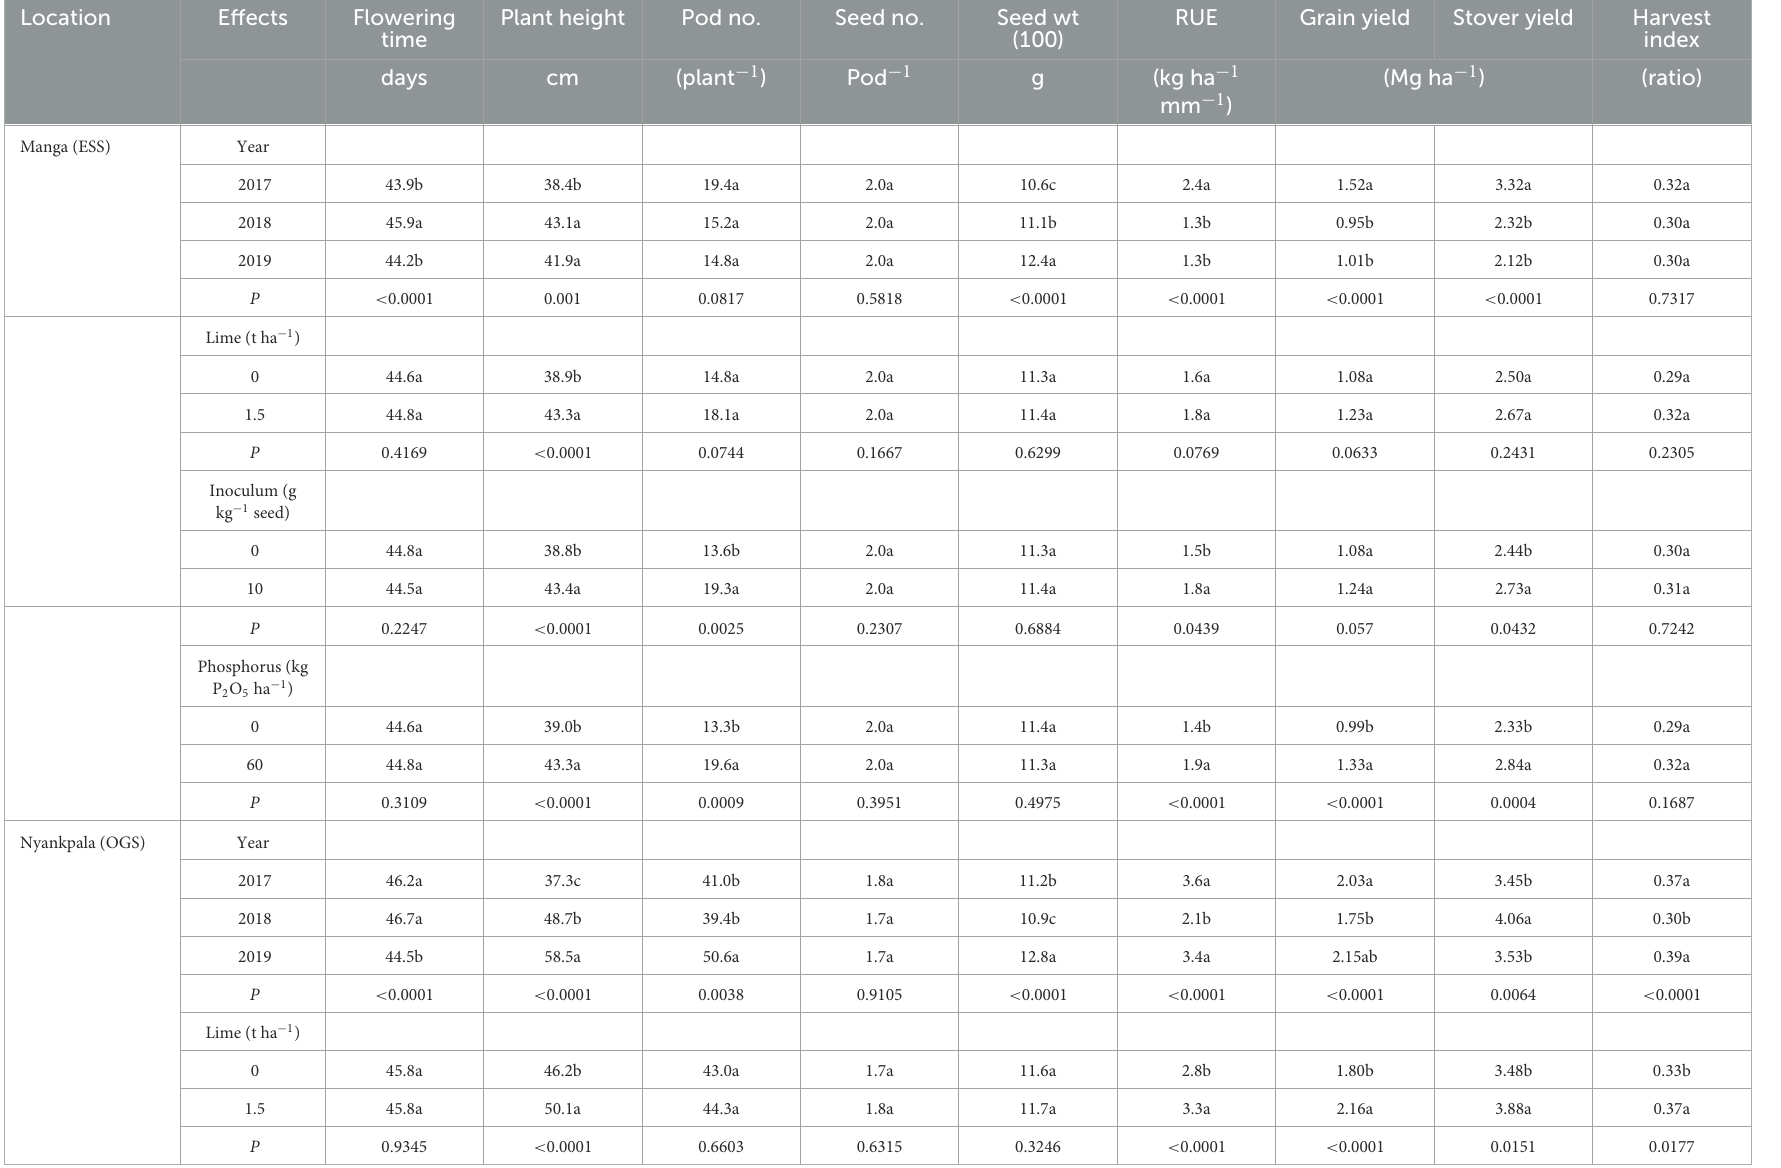
TABLE 5 Main effects of year, lime, inoculum, and phosphorus on yield, yield components, and rain use efficiency at Manga, Nyankpala, and Wa locations in the northern savannas of